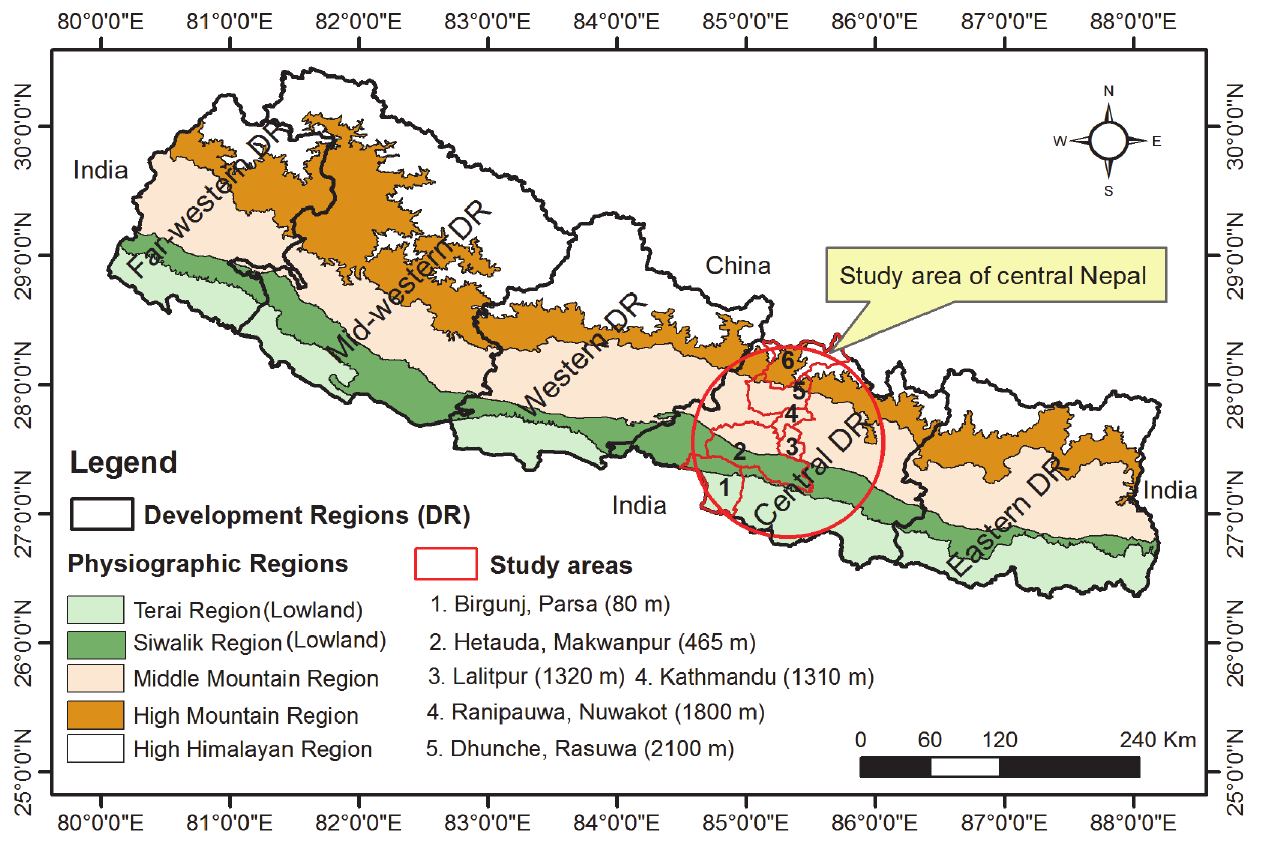
Fig 1. Map of study area. The map shows physiographic regions, development regions and study districts (sites) along an altitudinal transect from the lowlands (Birgunj; 80 m above sea level) to the High Mountain region (Dhunche; 2,100 m above sea level) in central Nepal. This map is updated from Dhimal et.al